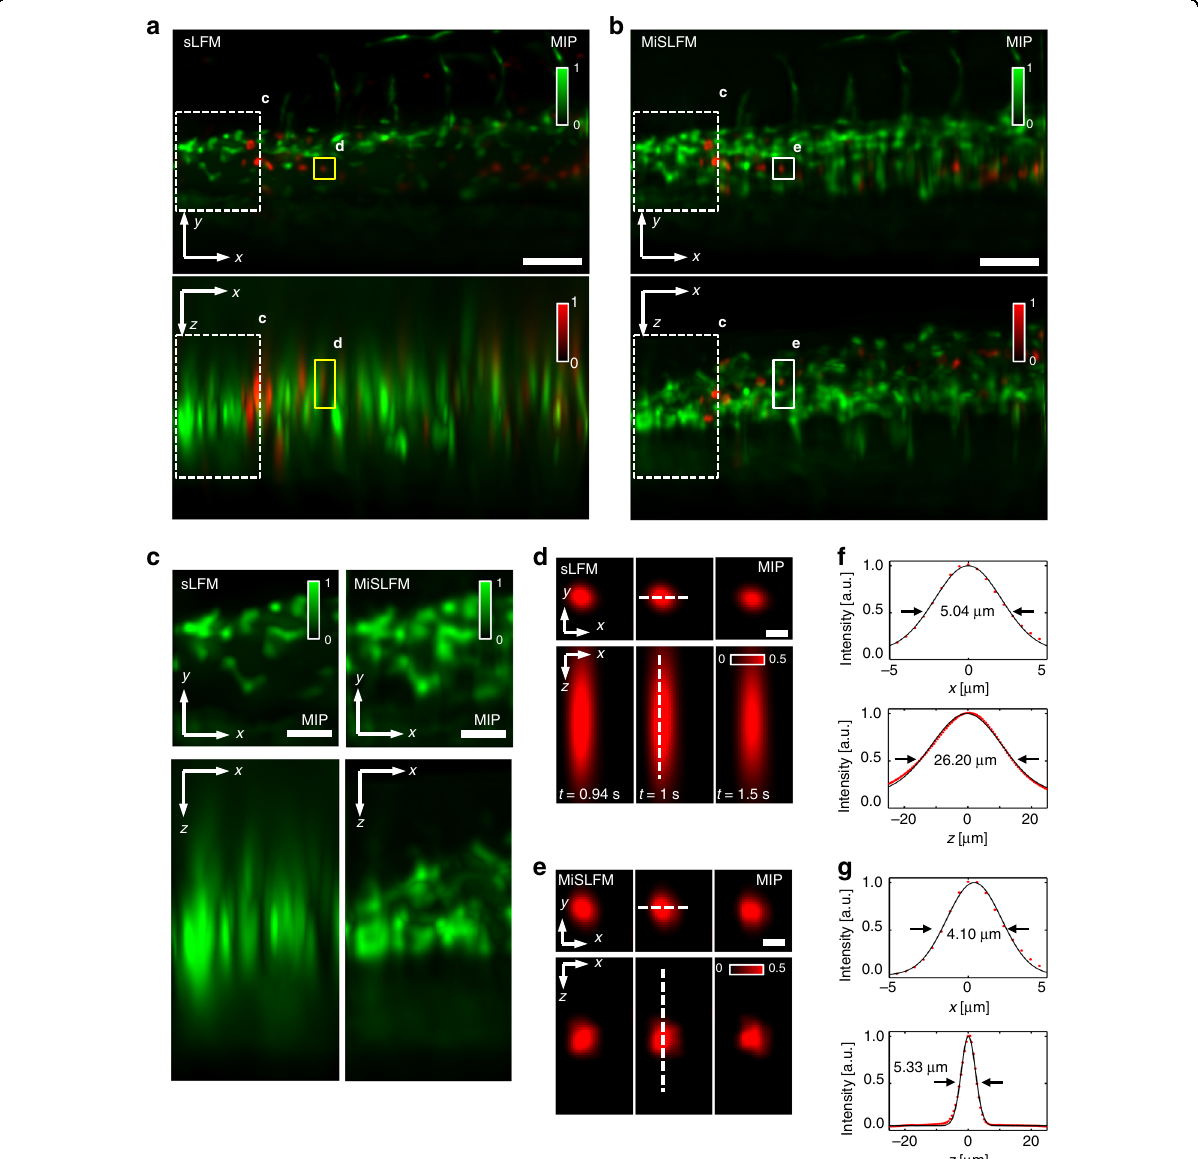
Fig. 5 High-speed volumetric imaging of zebra fi sh blood fl ow under low-illumination power. a , b MIPs of reconstructed blood vessels (green, 488 nm) and blood cells (red, 561 nm), for sLFM and MiSLFM under 0.54 mW mm − 2 (488 nm) and 0.71 mW mm − 2 (561 nm) illumination, demonstrating an obvious axial resolution improvement for MiSLFM under a 20×/0.5 NA objective. The blood vessels were only imaged once and the blood cells were imaged at an 18-Hz volume rate. c Magni fi ed areas marked by white dashed boxes in ( a , b ) by sLFM (left) and MiSLFM (right). d , e Magni fi ed areas marked by yellow and white boxes in ( a , b ) by sLFM (top) and MiSLFM (bottom), which shows that the axial resolution improvement indicates good consistency across different time frames for MiSLFM. f , g Intensity pro fi le along the white dashed line in ( d , e ), by sLFM ( f ), and MiSLFM ( g ), demonstrating an at least fi vefold improvement in axial resolution. Scale bars in ( a ) and ( b ) are 50 µm, in ( c ) is 20 µm, in ( d ) and ( e ) is 5